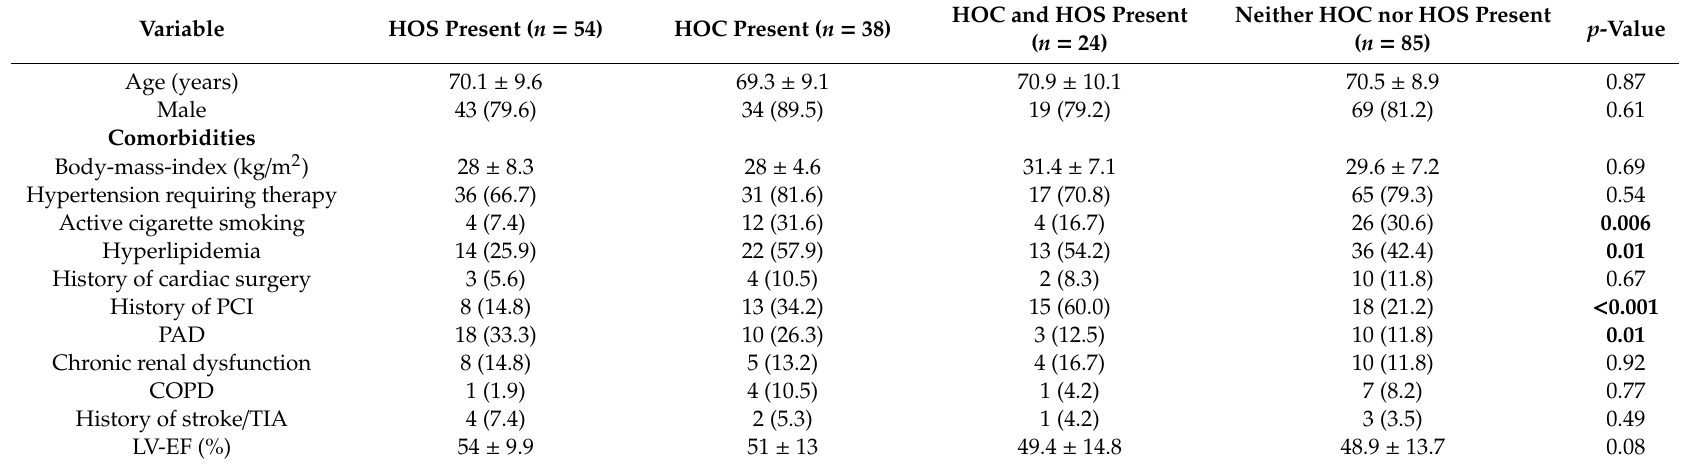
Table 1. Baseline